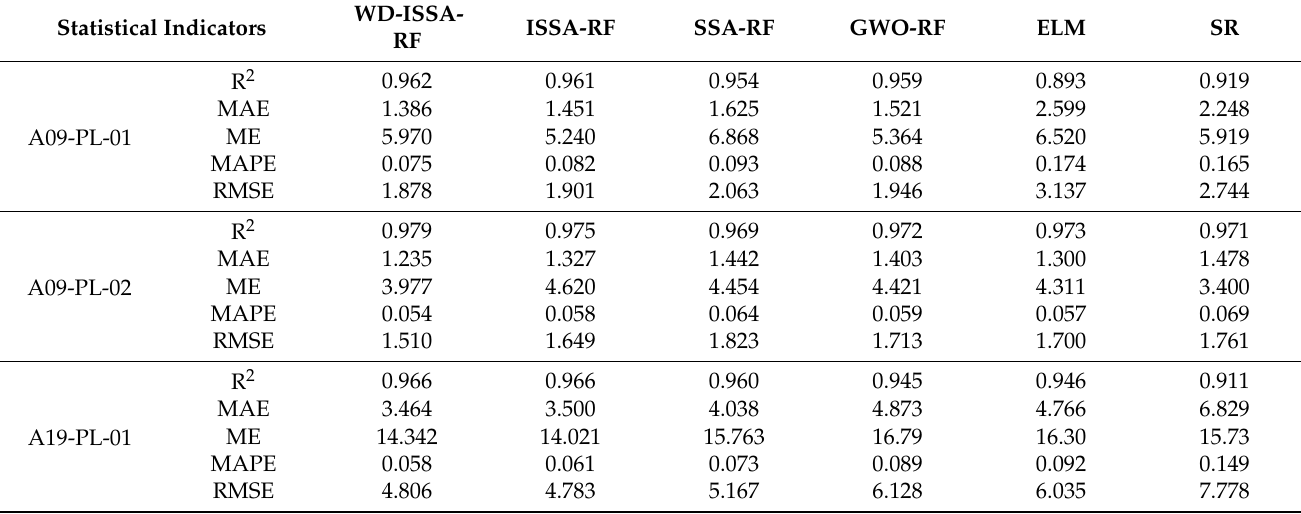
Table 1. Performance indexes of six prediction models for predicting dam deformation for three monitoring